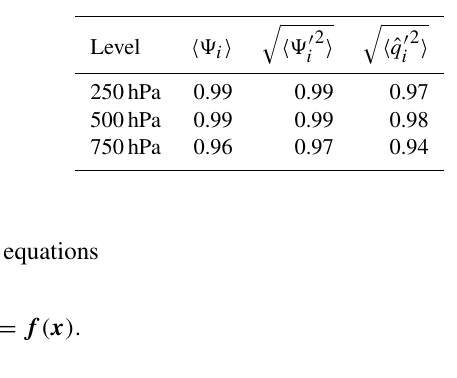
Table 3. Pattern correlation of various fields in the QG model with the corresponding fields in ECMWF reanalysis